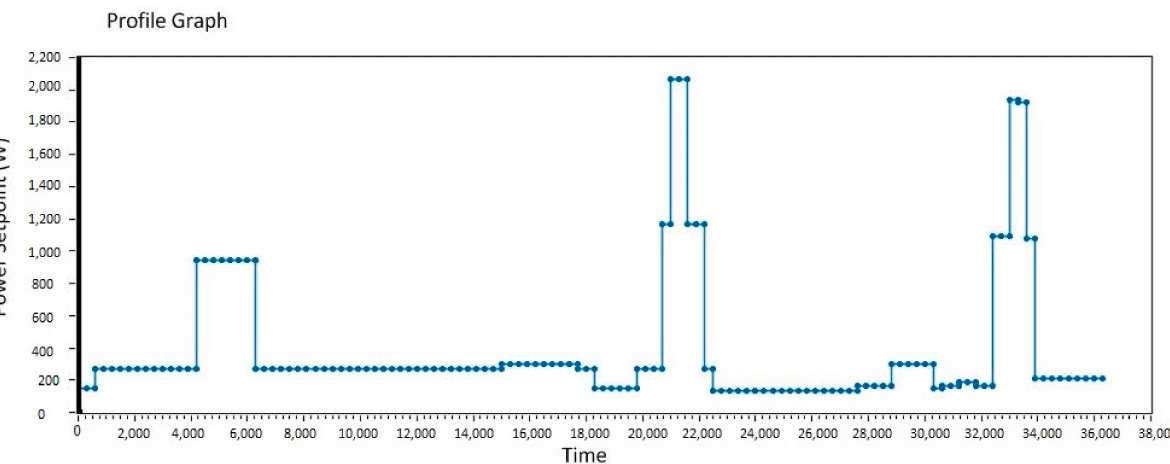
Figure 9. Consumption curve created by the programmable load (Plug